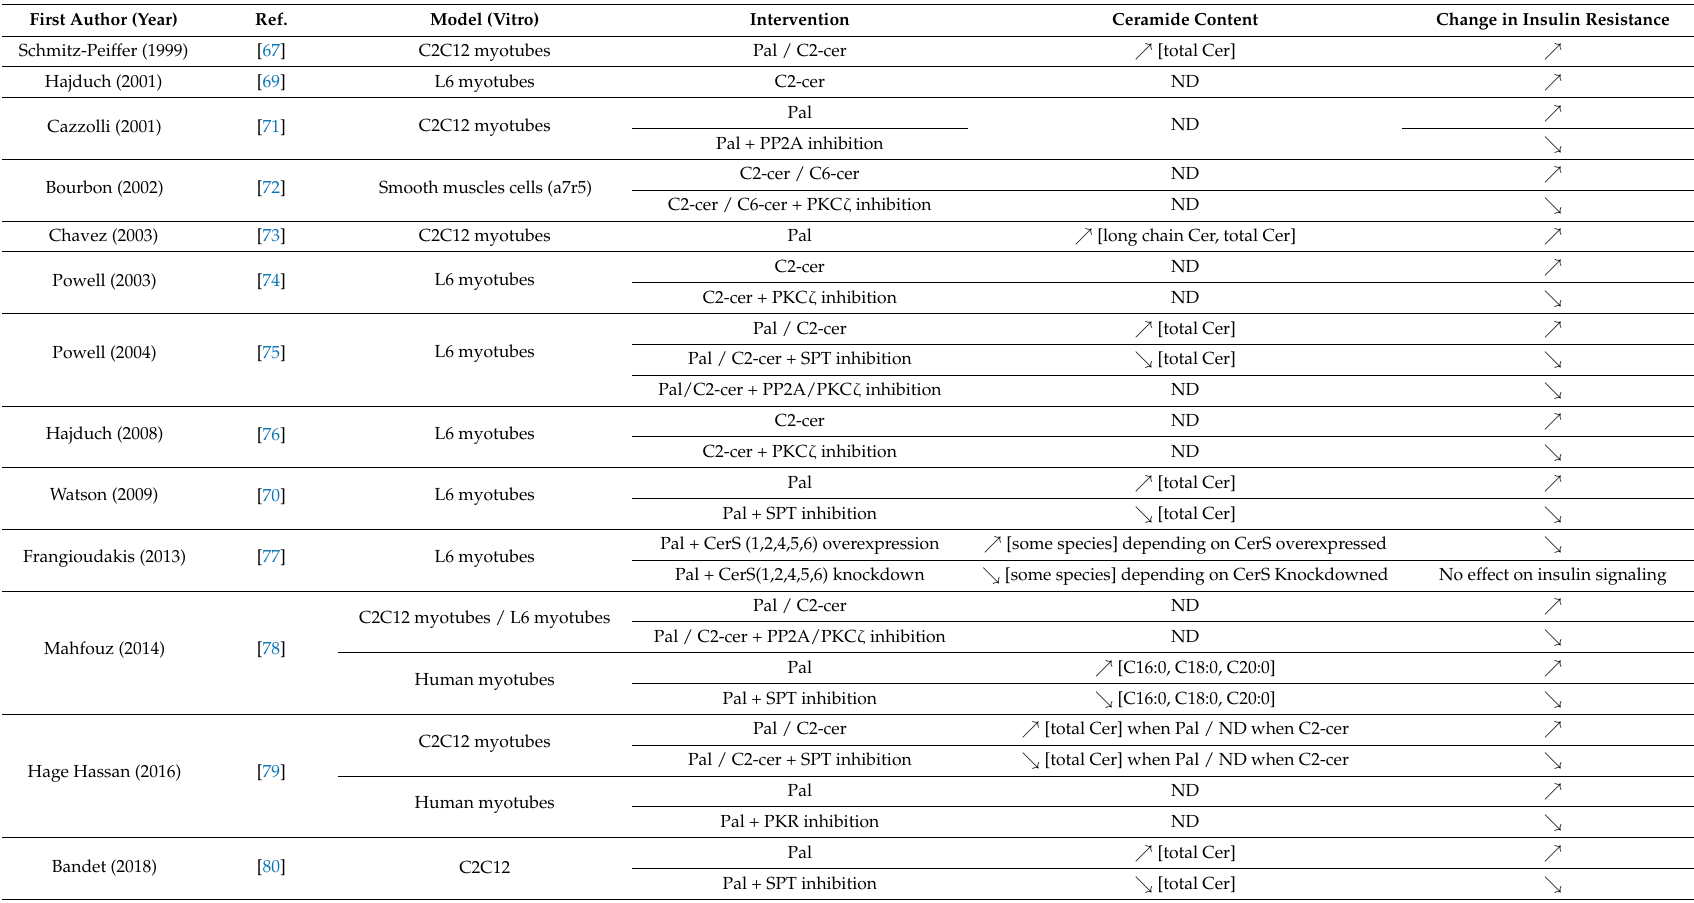
Table 1. Analysis of the relationship between muscle ceramide levels and insulin resistance. BMI: body mass index; C2-cer: C2-ceramides; C6-cer: C6-ceramides; Cer: ceramides; DES1: dihydroceramide desaturase 1; NGT: normal glucose tolerant; IGT: Impaired glucose tolerant; HFD: high fat diet; Pal: palmitate; SPT: serine palmitoyl transferase; T2D: type 2 diabetes; [ ]: concentration; ND: not